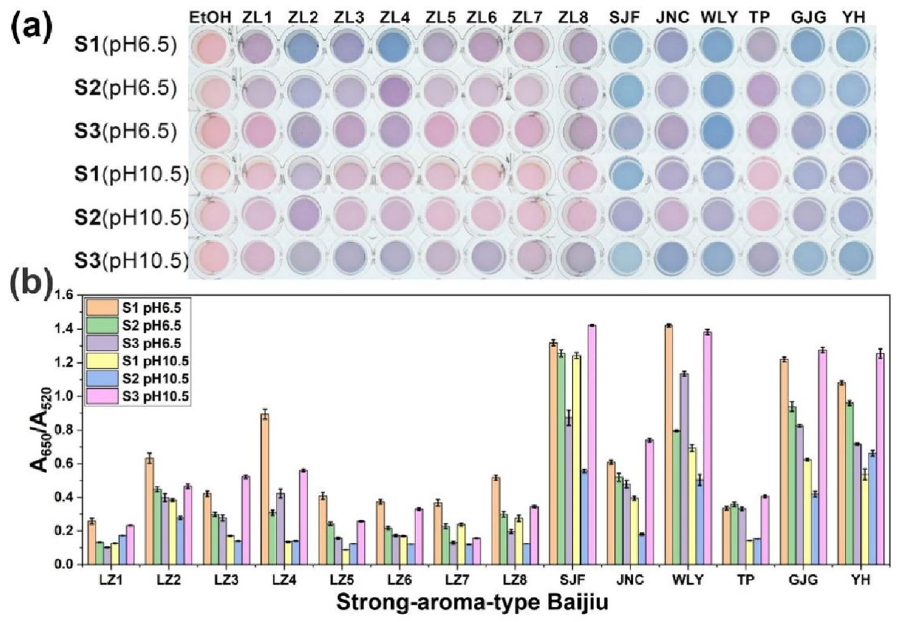
Figure 5. ( a ) Color change patterns and ( b ) response (A650/A520) patterns of 14 kinds of SAB samples obtained using the sensor array based on AA@AuNPs.